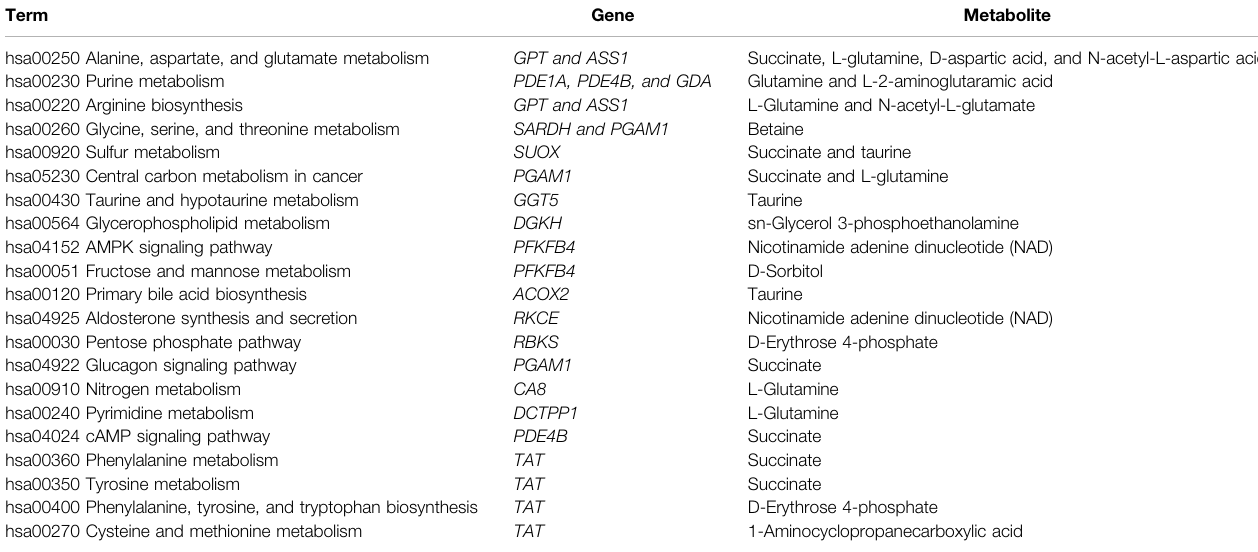
TABLE 1 | Functional enrichment analysis for differential genes and metabolites involved in tadala fi l treatment on CRC. Term